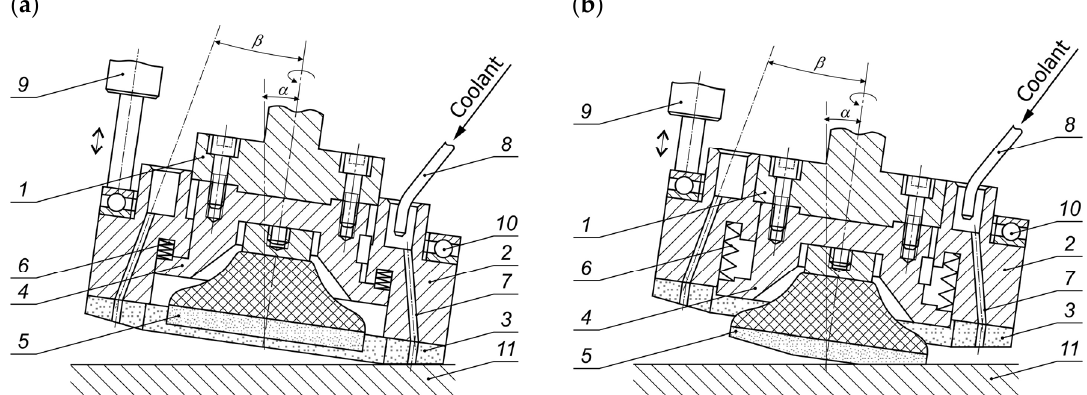
Figure 1. Conceptual diagram of a dual-tool grinding head (1—grinding head body; 2—grinding wheel body; 3—ring-shaped bonded grinding wheel; 4—flexible abrasive disc holder; 5—flexible abrasive disc; 6—spring; 7—coolant feed channels; 8—coolant feed nozzle; 9—pneumatic actuator; 10—thrust bearing; 11—workpiece): ( a ) in the rough grinding setting; ( b ) in the finishing grinding setting [32].